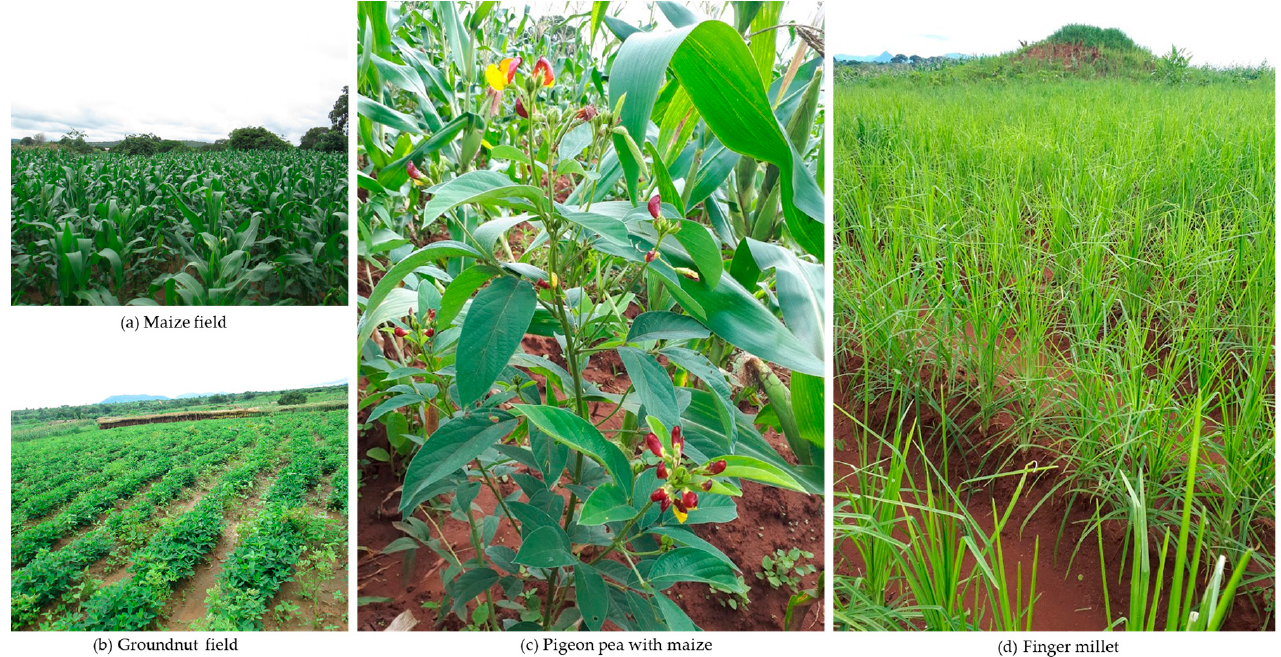
Figure 2. Examples of crops photographed in the study locations during the 2019/2020 growing season.